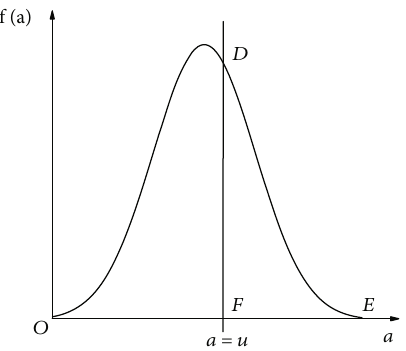
Figure 12: Schematic representation of an aperture